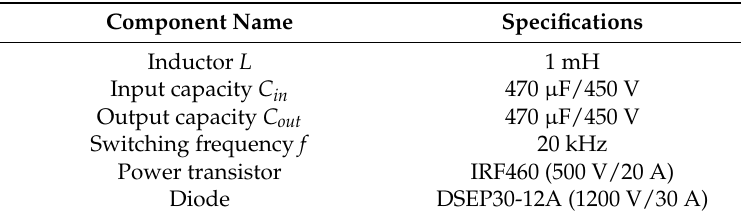
Table 4. Rated configuration values of the boost converter.